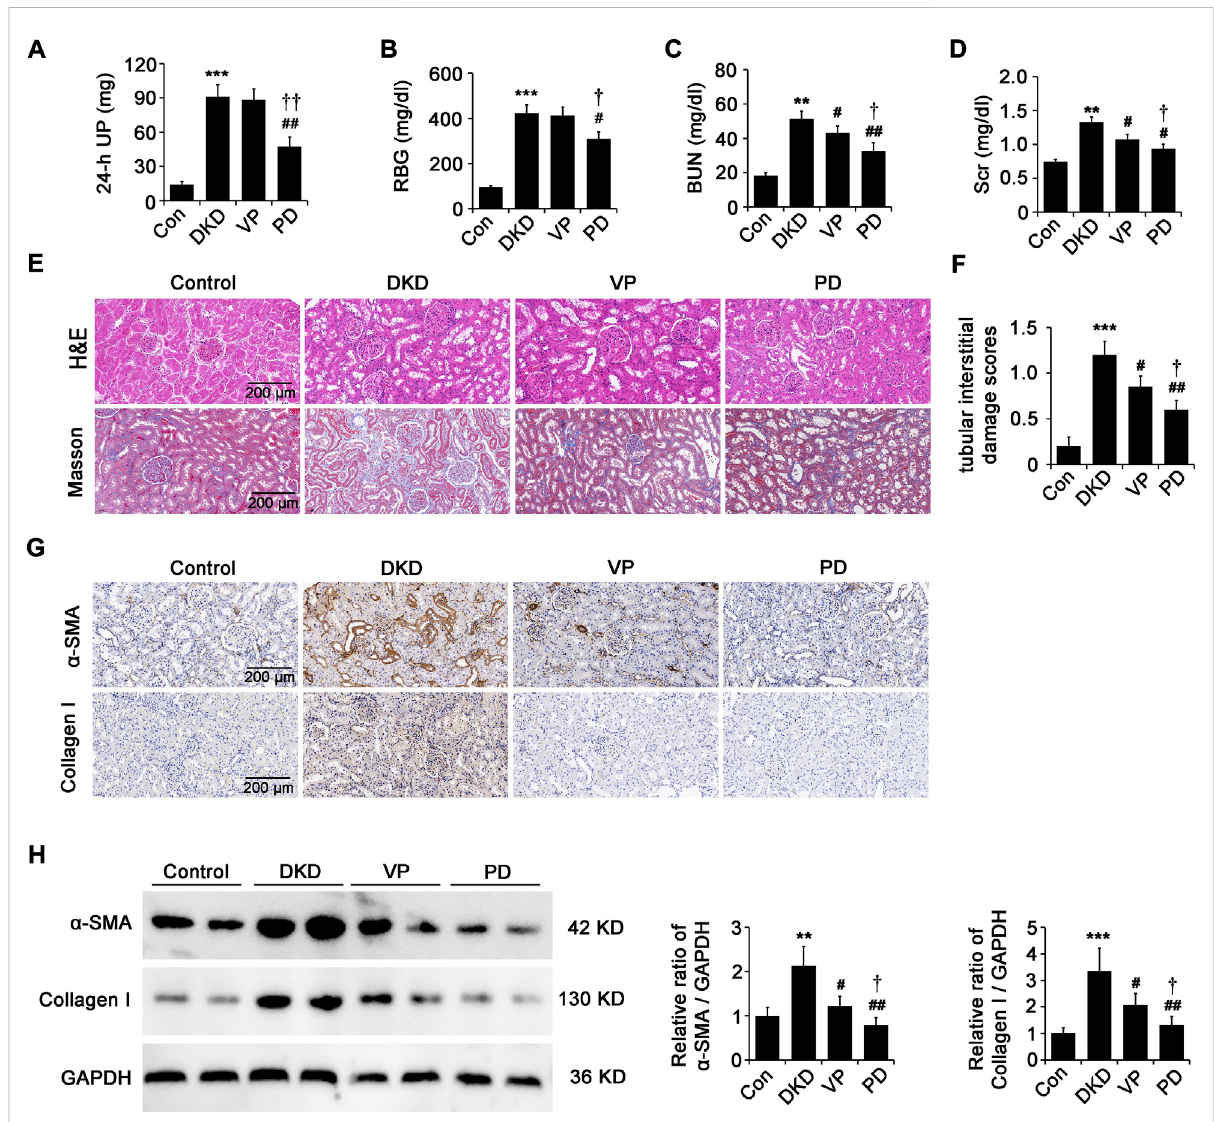
PD is superior to VP in alleviating renal injury and fi brosis in DKD rats. (A – D) The 24 h-UP (A) , RBG (B) , BUN (C) and Scr (D) were measured at 8 weeks after successful DKD modeling. (E) Histopathology analysis of the kidneys was performed by hematoxylin-eosin (H&E) staining and masson staining. (F) Tubular injury as assessed by tubular interstitial damage scores. (G) Immunohistochemical staining of α -SMA and collagen I in renal paraf fi n tissue of different groups. (H) Western blot analysis of α -SMA and collagen I in different groups. UP, urine protein; RBG, random blood glucose; BUN: blood urea nitrogen; Scr: serum creatinine; DKD, diabetic kidney disease; VP, vertepor fi n; PD, polydatin; α -SMA, alpha-smooth muscle actin. * p < 0.05, ** p < 0.01, *** p < 0.001 vs control (Con); # p < 0.05, ## p < 0.01, ### p < 0.001 vs DKD; † p < 0.05, †† p < 0.01, ††† p < 0.001 vs